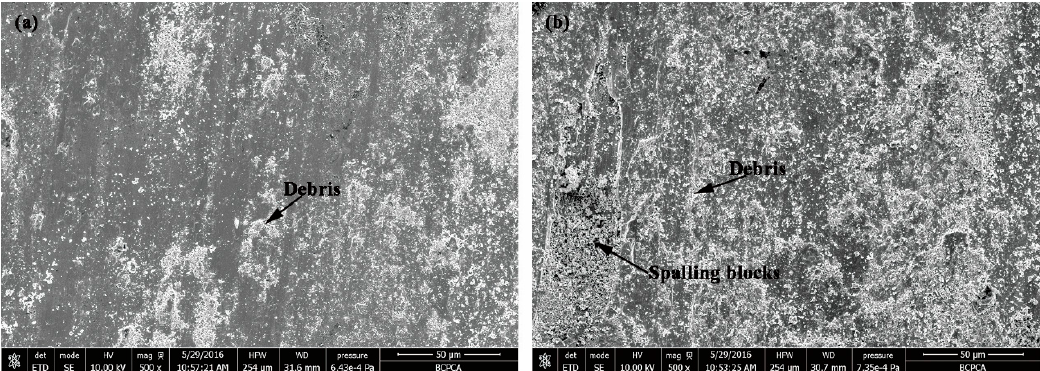
Figure 12. The SEM images of wear surface: ( a ) CZ; ( b ) S.